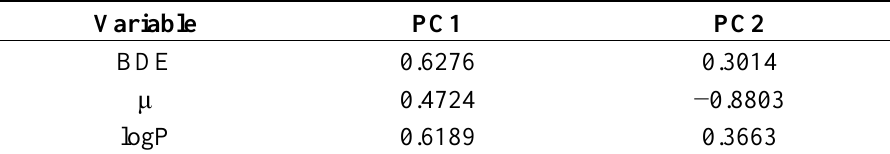
Table 6. Loading vectors for the first two principal components.